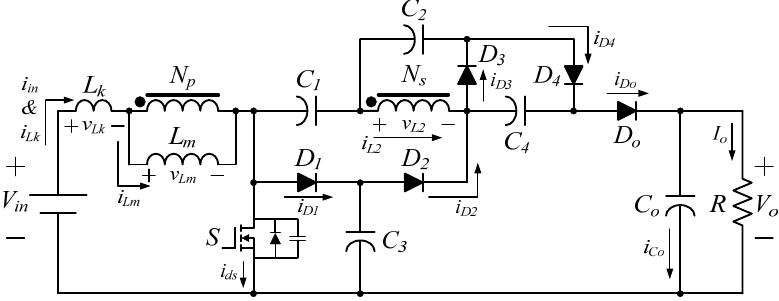
Figure 3. Definition of voltage polarity and current